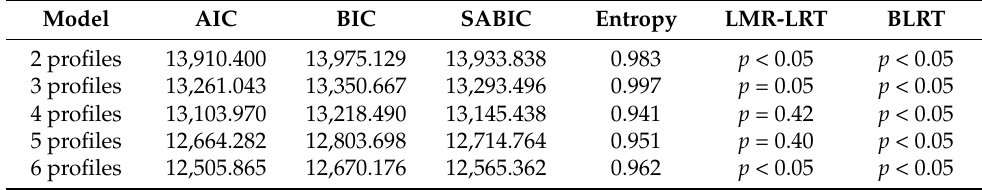
Table 4. Fit indices for models with number of profiles ranging from 2 to